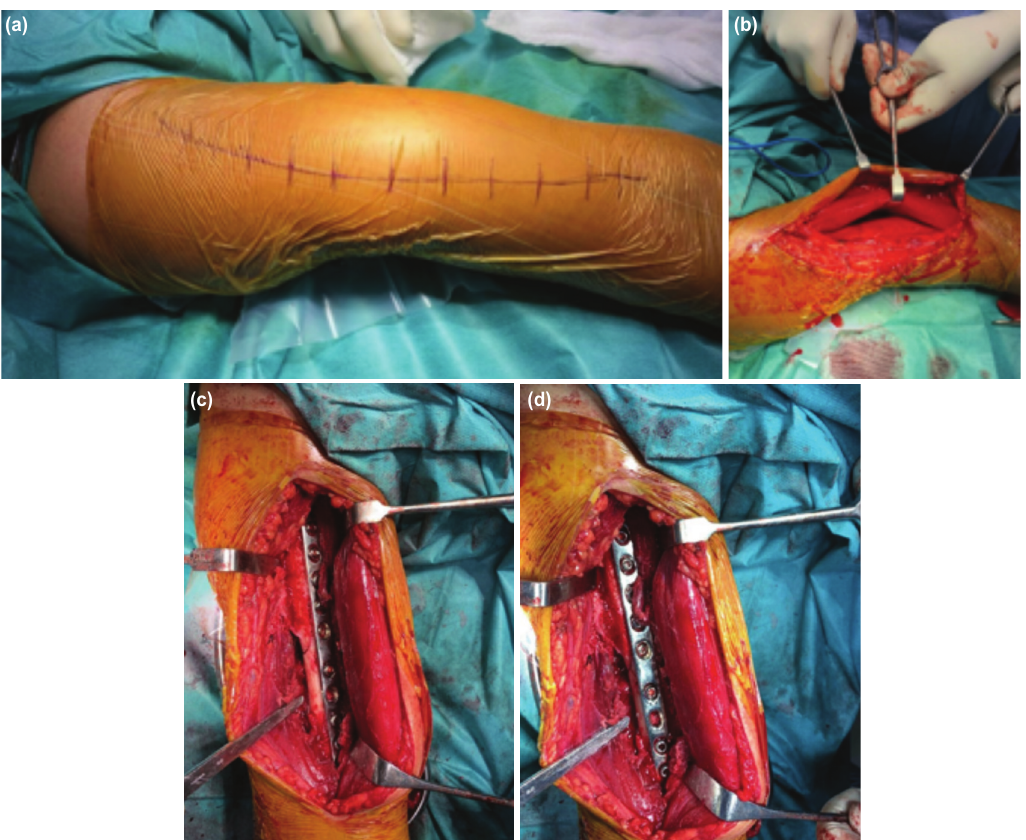
Medial plating is being done and application of plate on flat medial surface of humerus. Clockwise – (a) skin incision, (b) biceps Fig. 1: retracted laterally, (c,d) brachialis was elevated subperiosteally and plate applied.